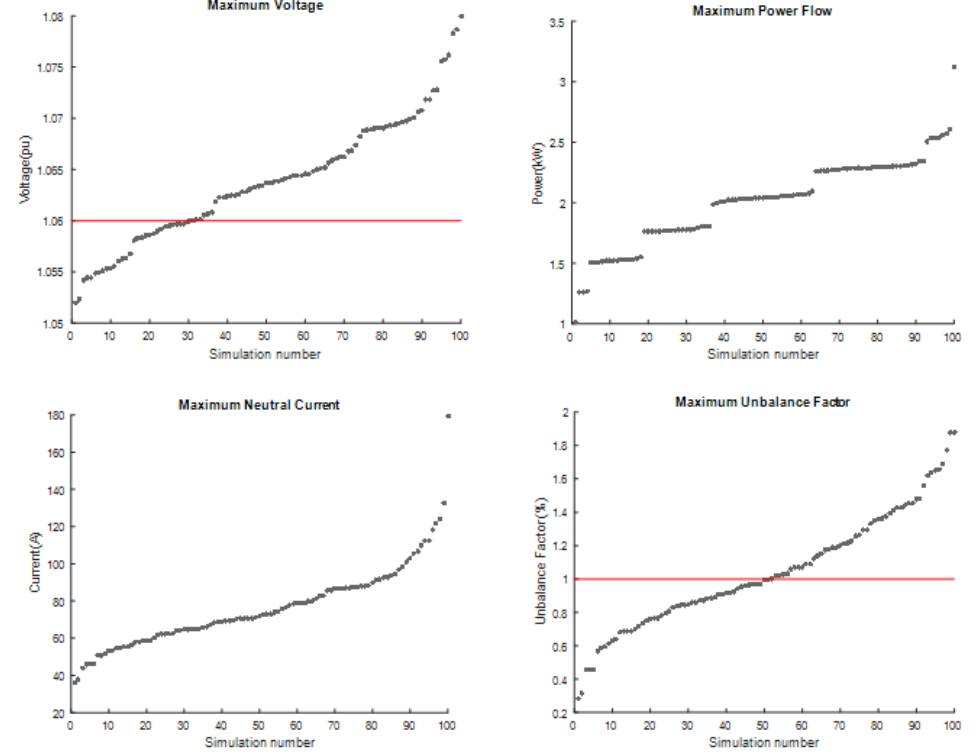
Figure 7: Variation of maximum voltage, maximum power flow, maximum voltage Unbalance factor and neutral current for hundred simulations (Case 2).